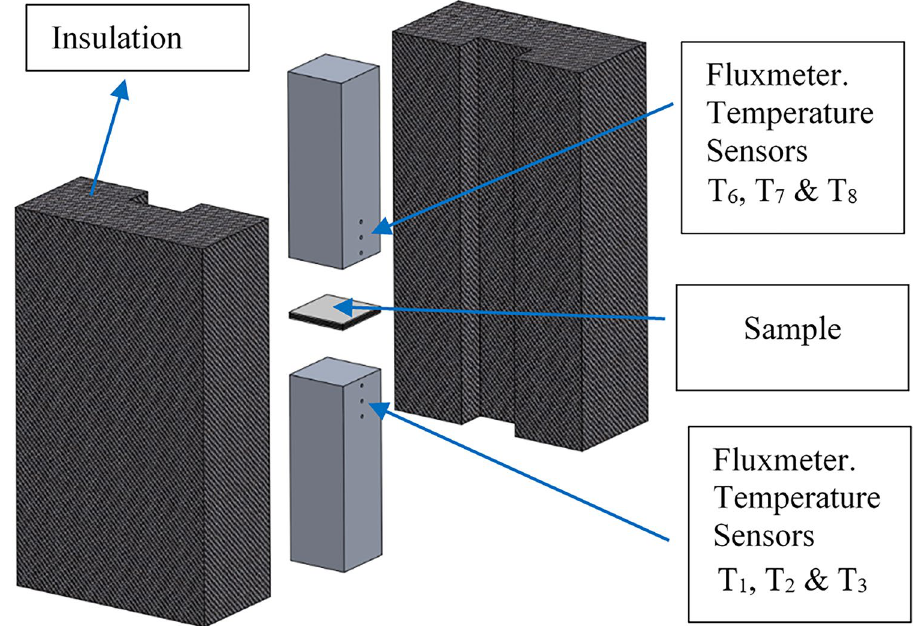
Fig. 2 Sample and tempera- ture sensors